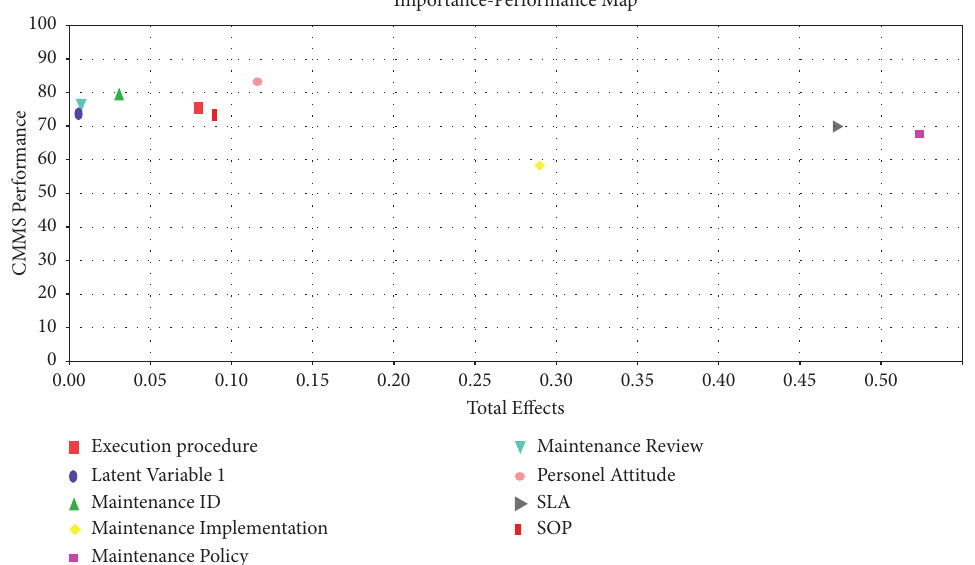
Figure 5: Importance-performance map construct standardised